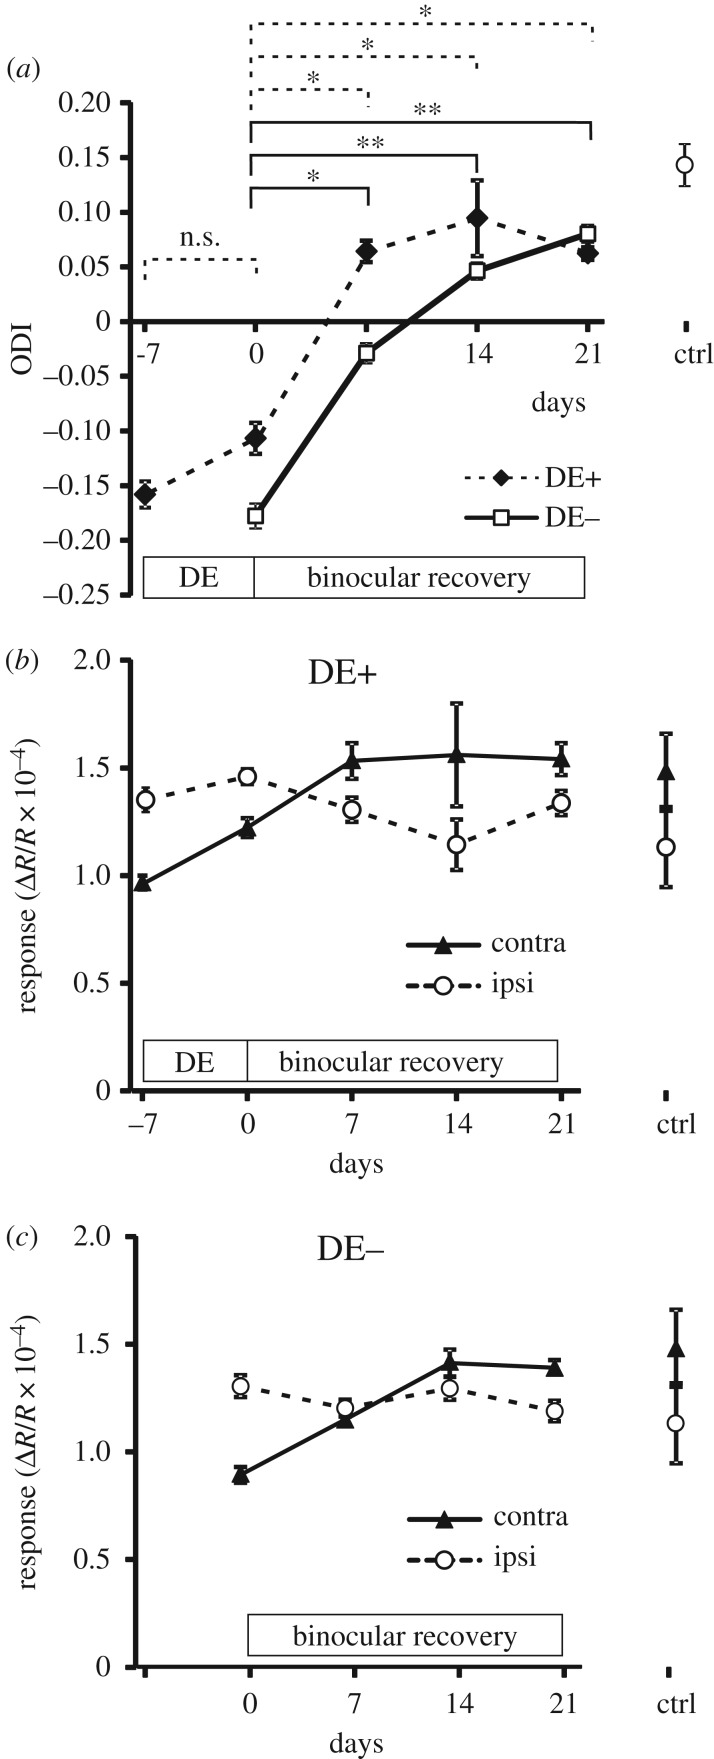
Time course of ODI and of left- and right-eye response magnitudes obtained from chronic intrinsic signal imaging of mice with (DE+) and without a week of dark exposure (DE−) following MD. (a) Changes in ODI for DE+ (filled circles, dotted lines) and DE− cohorts (open squares, solid lines). Significant changes are indicated for the DE+ group (dotted line brackets) and DE− group (solid line brackets); n.s., non-significant; *p < 0.05; **p < 0.01 (Holm-Sidak multiple comparisons test). (b) Magnitude of responses through the contralateral previously deprived eye (filled triangles, solid lines) and the ipsilateral eye (open circles, dashed lines) in the DE+ cohort. (c) Magnitude of contra- and ipsilateral eye responses in the DE− cohort.